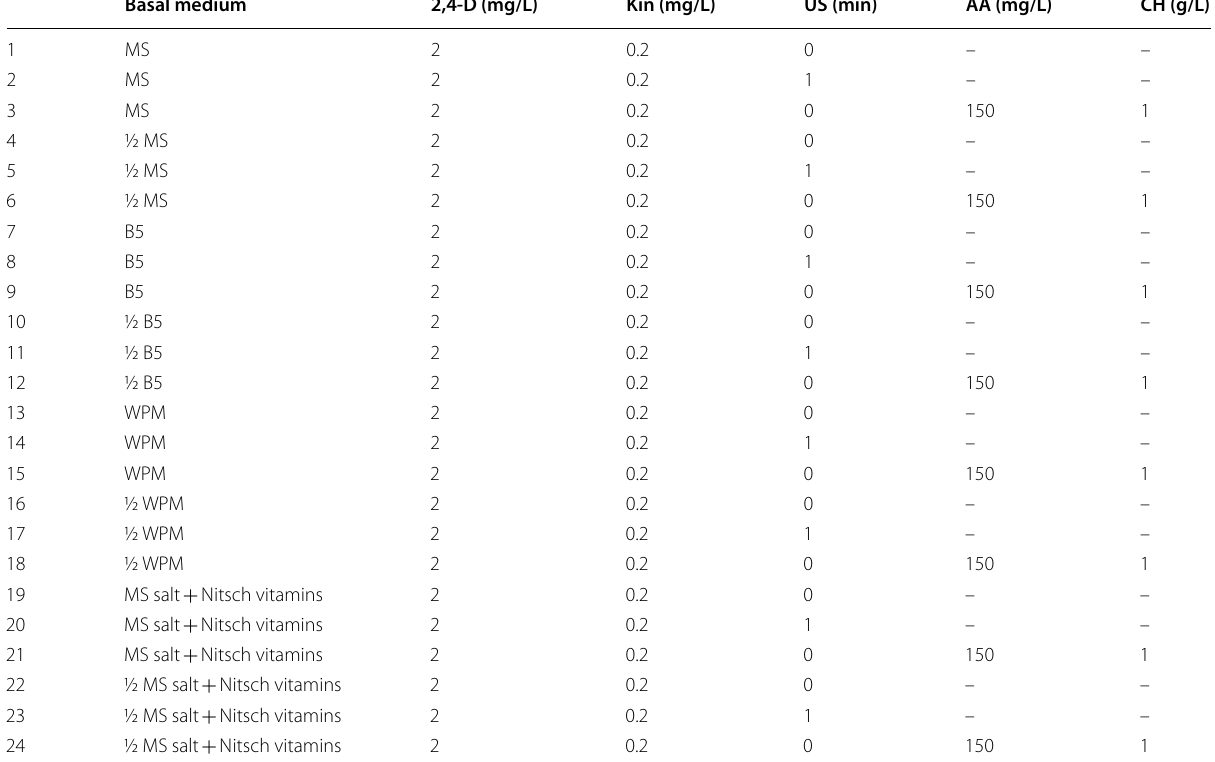
Table 2 Different basal media used for callus induction and growth from hazelnut Basal